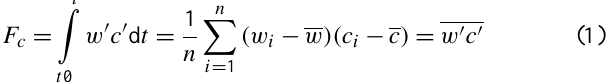
Figure 2. Data collection scheme for fluxes of NO ( a : 2ch-CL) and NO 2 ( b : TD-LIF) and vertical gradient (c) measurements. Colors represent the different measurement heights: 18m (black), 9m (blue), 5m (green), and 0.5m (gray). Yellow periods are calibration cycles and white periods represent times when diagnostics were collected.